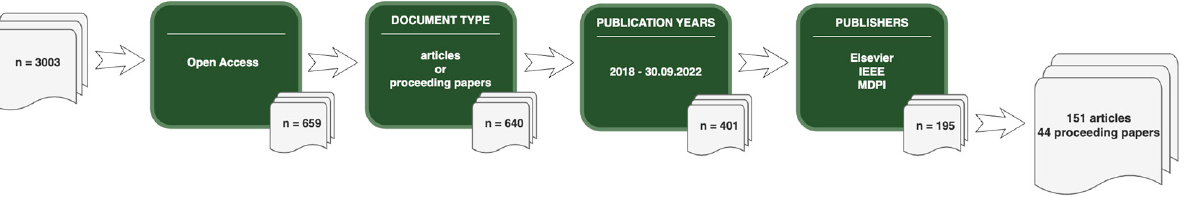
Figure 2. Screening stage.